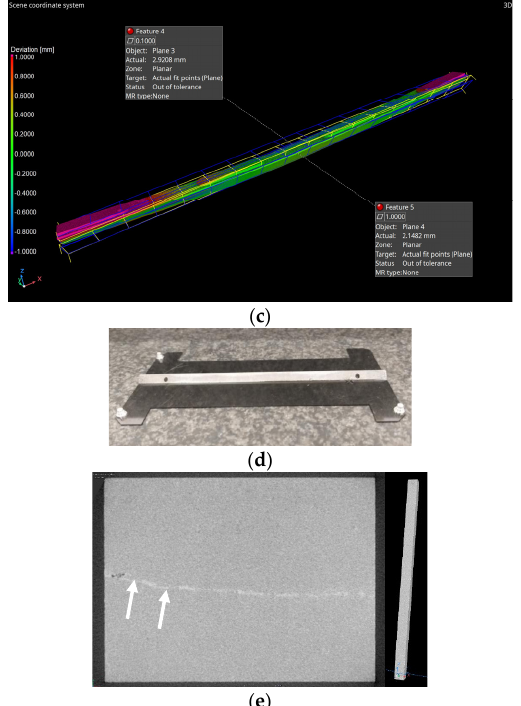
Figure 4. ( a ) General view showing severe bending and ( b ) CT cross-section of sample No.25 stored in extreme conditions. Flaws (identified by arrows) emerge in the glue volume. ( c ) The out-of-flatness is 2.9 mm while the lateral deflection is 2.15 mm. ( d ) General view of a subassembly including a GPI adapter. ( e ) CT cross-sectional view of the GPI adapter (sample No.7), also exposed to extreme conditions. Segregation bands and cavities (identified by arrows) are present in the bulk of the adapter, but there is no deformation of the sample. Conventional metrology measurements performed on a large number of subassem- blies, including PM and GPI adapters, respectively, confirmed that the former underwent a high deformation following the temperature-humidity cycles, while the latter remained substantially undeformed under the same conditions (Figure 5).